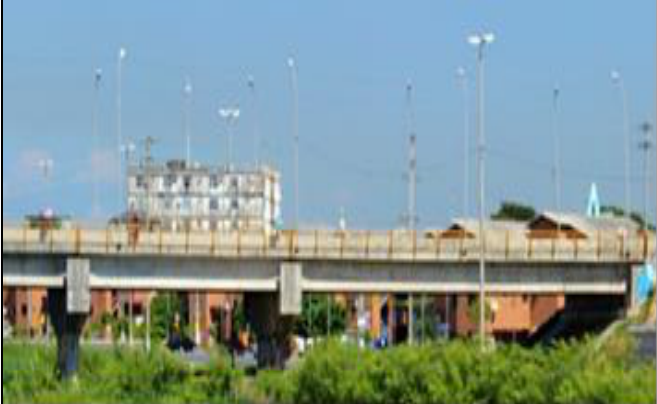
Figura :Igarapé do quarenta a ponte do bairro morro da liberdade. Fonte: Autores, (2018).